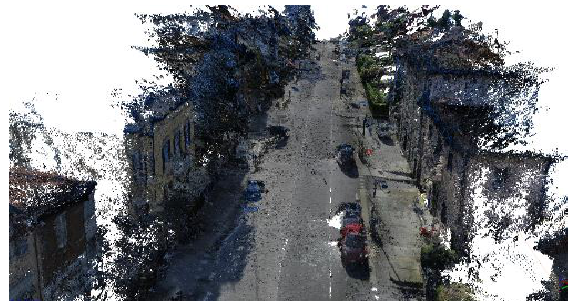
Figure 5. The reference dense cloud point of Via San Polo